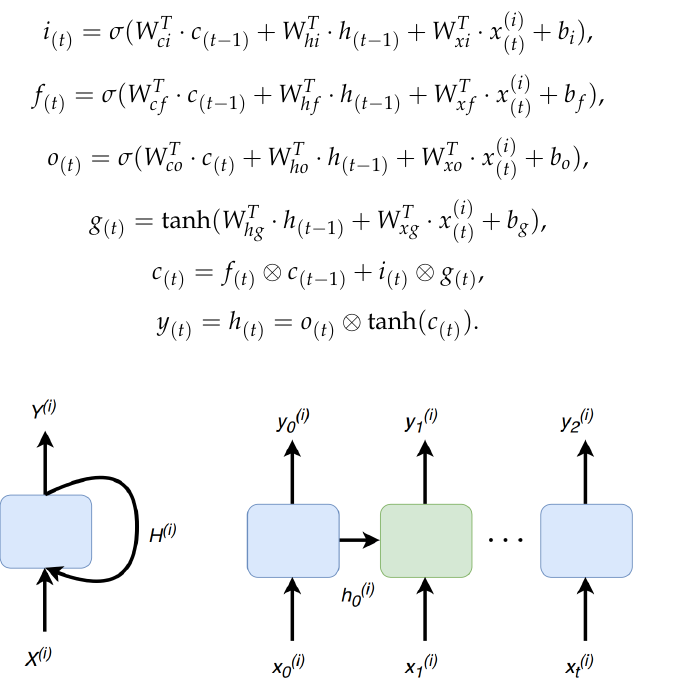
Figure 4. A recurrent layer and its unrolled through time representation. A multi-temporal, multi-spectral pixel X ( i ) is made by a sequence of time steps, x h ( i ) feed the next iteration of the